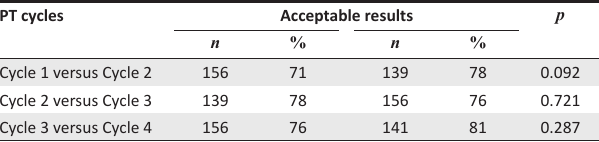
TABLE 3: Comparison of participating laboratories’ performance between cycles in Togo from July 2016 to December 2016. PT